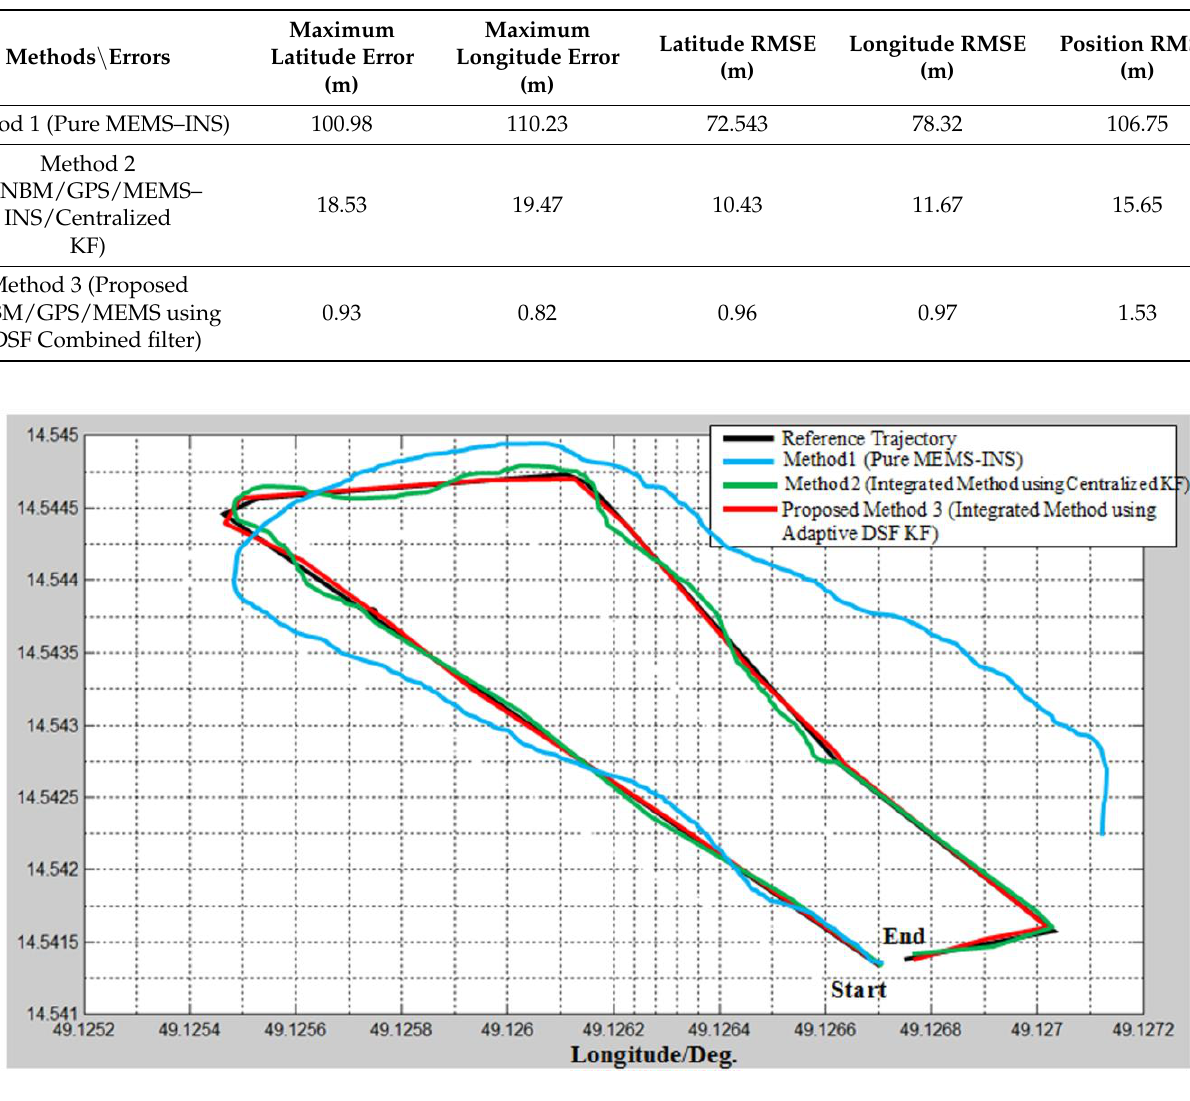
Table 2. Estimated position errors with the three integrated methods.